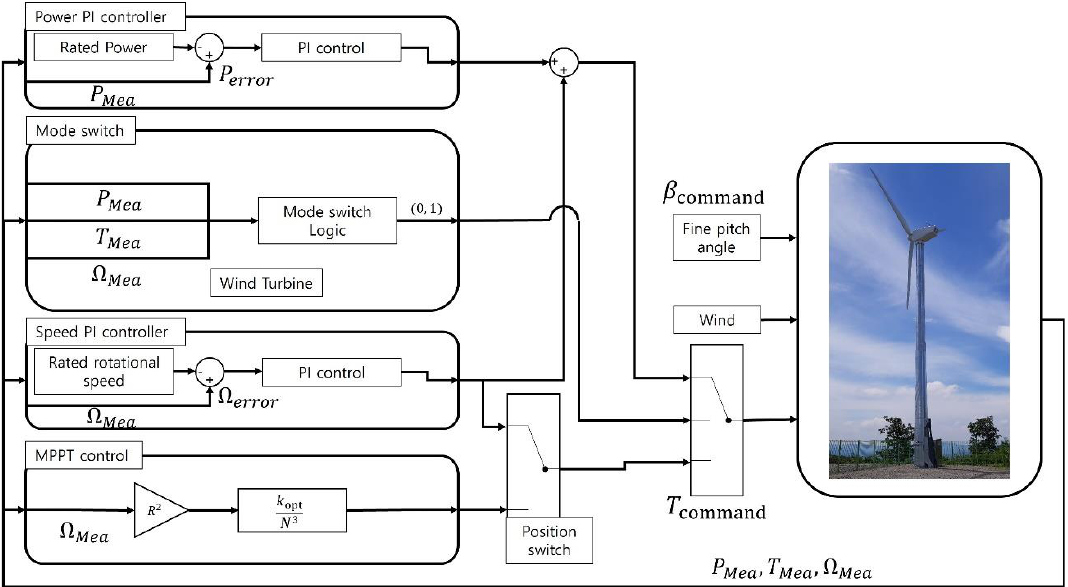
Figure 6. Block diagram of the power control algorithm of variable-speed fixed-pitch wind tur- bine.